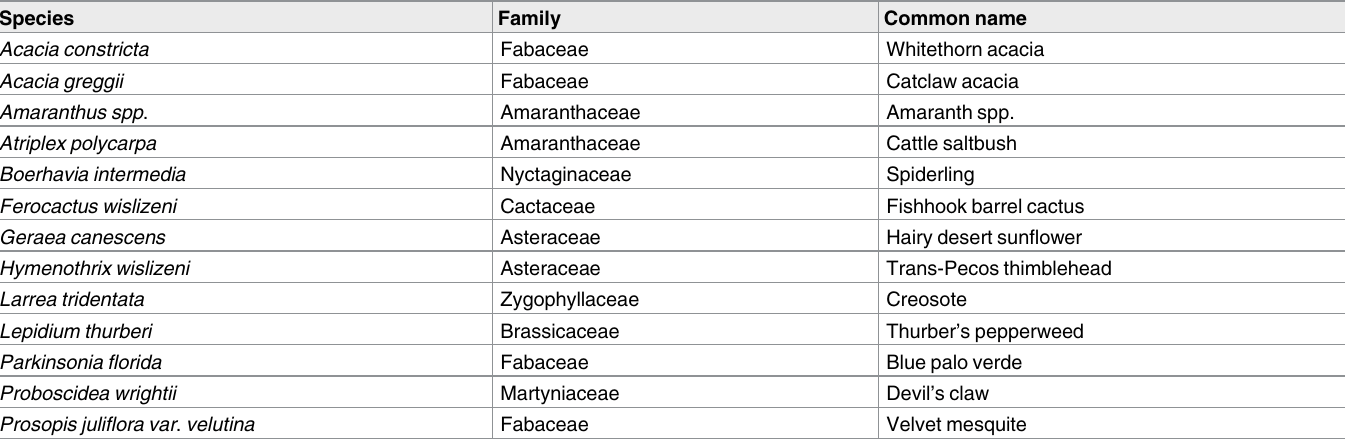
Table 1. Plants visited by honey bee foragers originating from the sentinel colonies at the RRAC experimental apiary (Pinal County, AZ, USA). Species